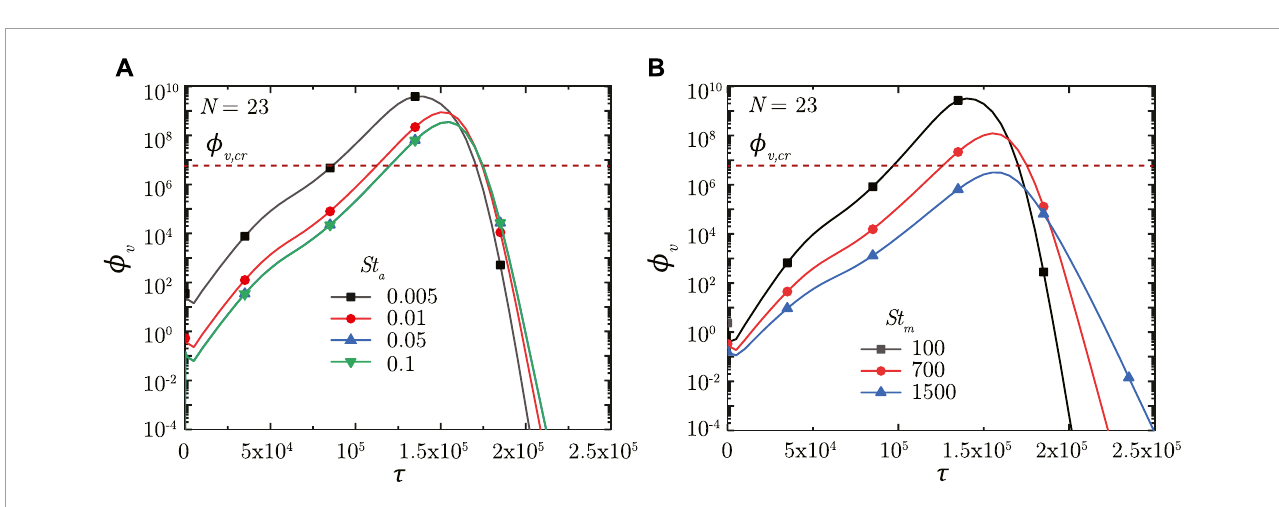
FIGURE 6 Temporal change in dimensionless virus concentration ( ϕ v ) at N = 23 (deep lung) for various (A) St a and (B) St m . The dotted line indicates the critical viral load ( ϕ v , cr ) in the deep lung required for pneumonia onset (Fajnzylber et al., 2020; Wölfel et al.,